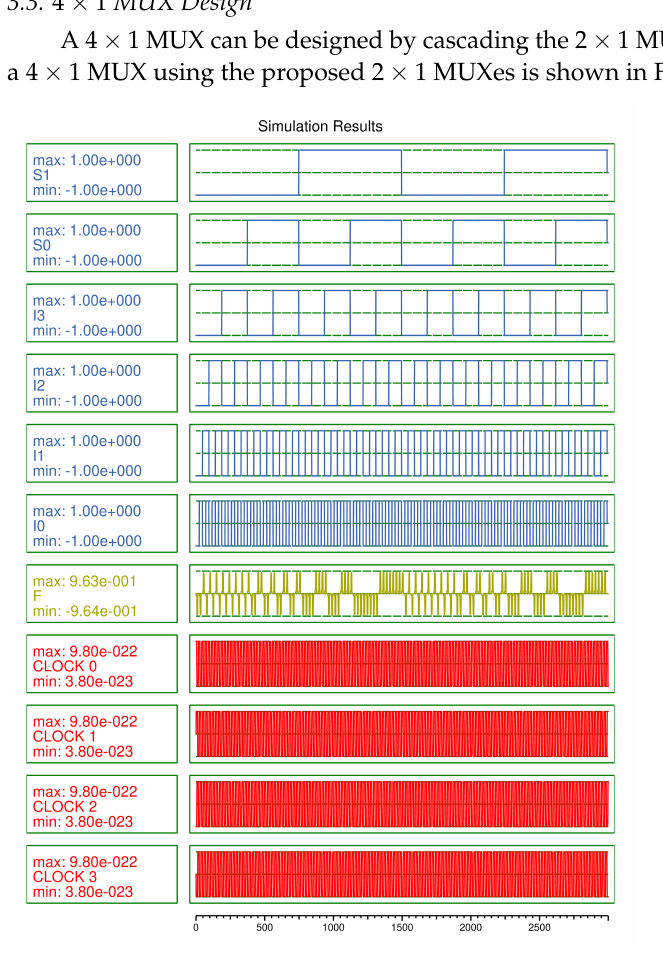
Figure 6. Simulation result of proposed 4 × 1